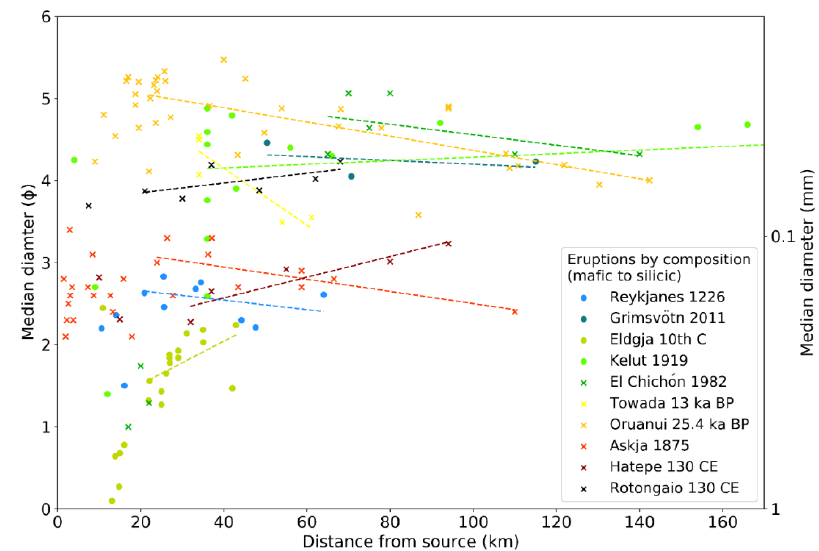
Figure 5. Change in median grain size with distance from source for hydromagmatic eruptions sampled > 20 km from source. Symbols represent eruption size: x VEI ≥ 5, o VEI ≤ 4. Dashed lines are straight-line fits to data > 20 km, except for El Chichon which uses ≥ 65 km.